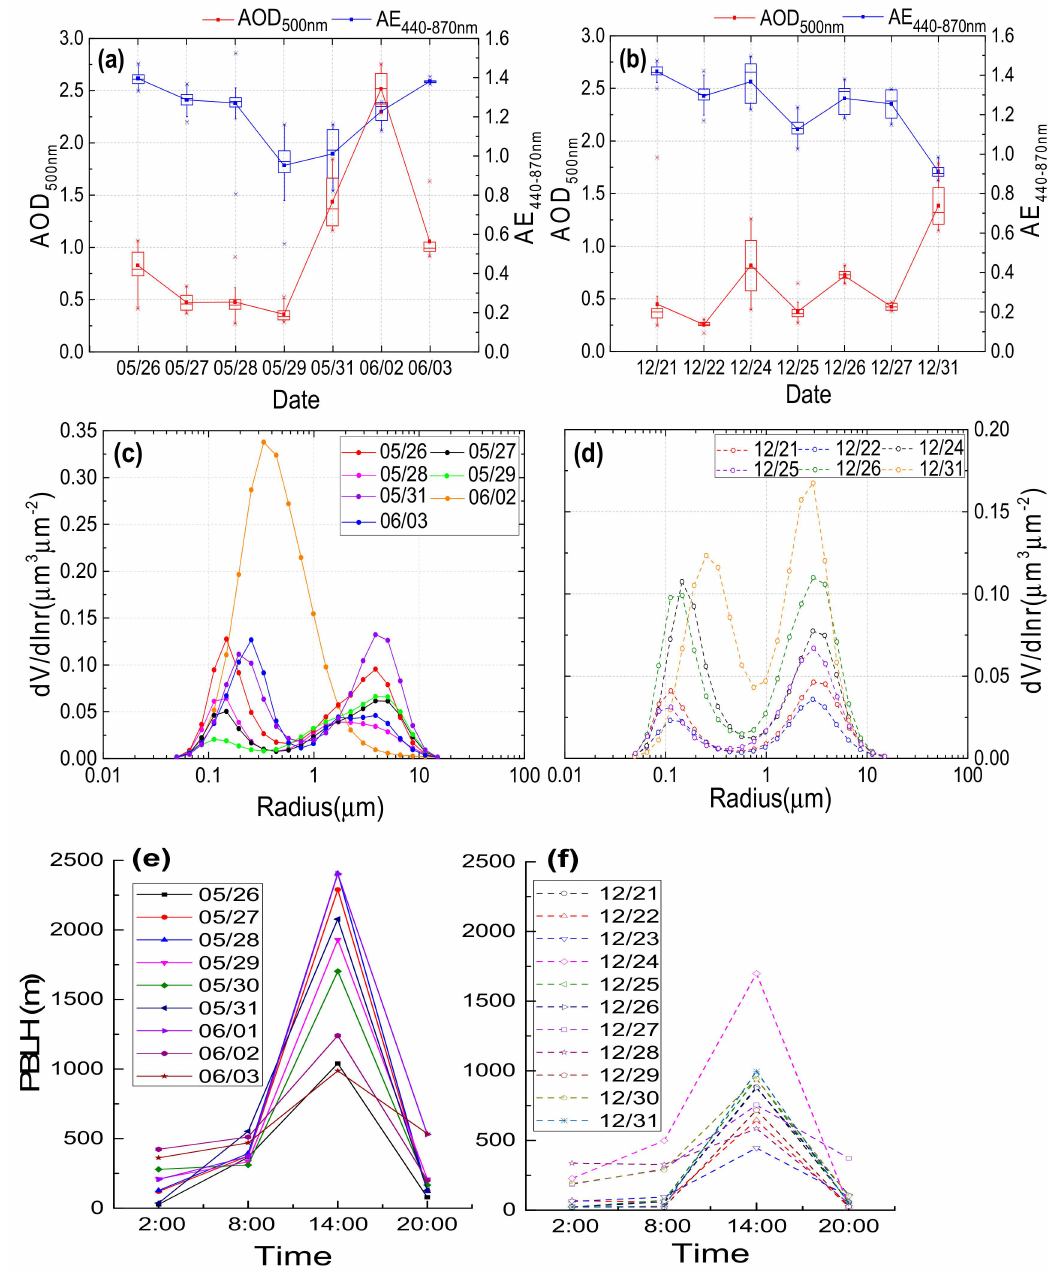
Figure 5. Daily averaged ( a , b ) AOD (aerosol optical depth) at 500 nm (AOD 500 nm ) and AE (Angstrom Exponent) at 440–870 nm (AE 440–870 nm ), ( c , d ) VSD (volume size distribution), ( e , f ) PBLH (planetary boundary layer height) during the two pollution episodes. PBLH was provided from the National Center for Environmental Prediction’s 1 ◦ -grid-spacing operational Global Forecast System Final Analyses. The relative contributions of fine and coarse mode aerosol particles to the aerosol content